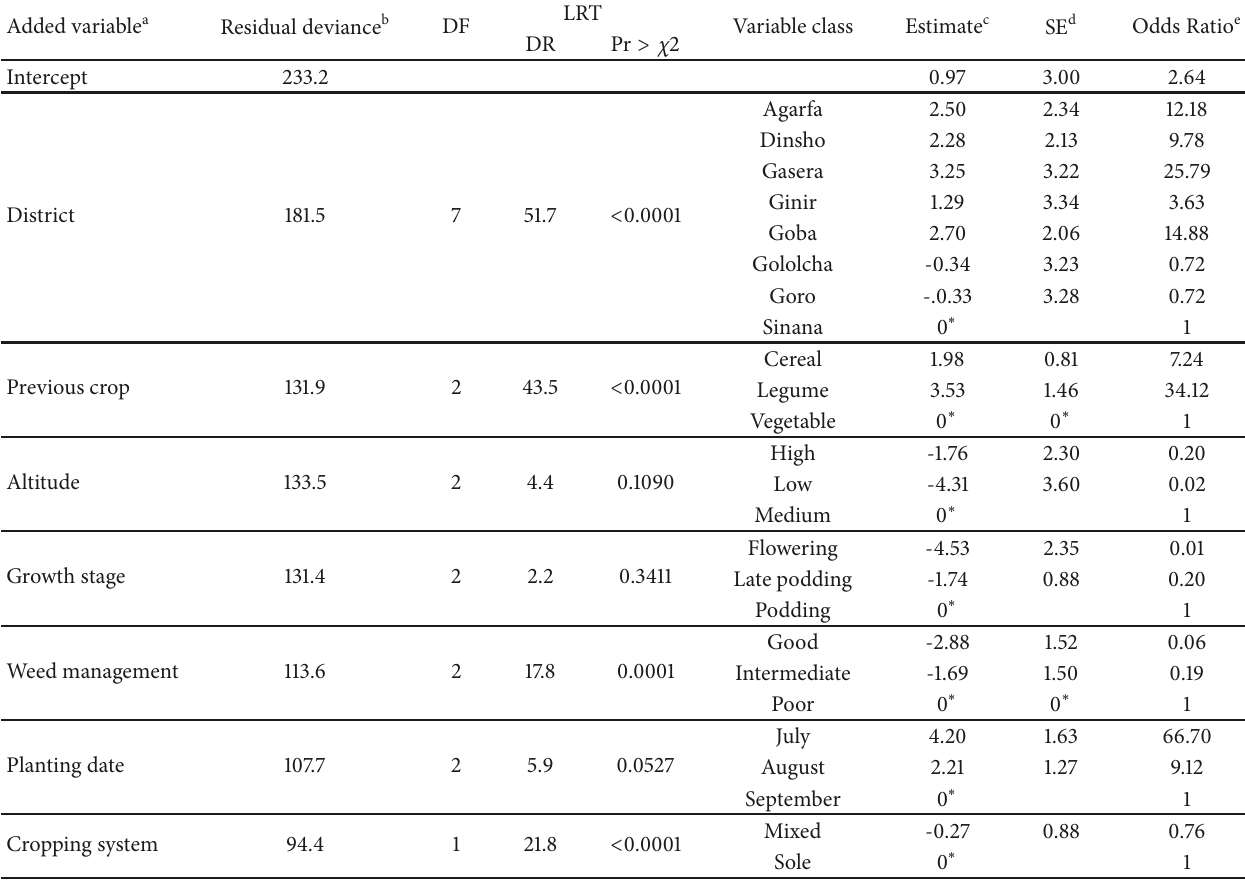
Table 5: Analysis of deviance,natural logarithms of odds ratio, and standard error of added variables in a reduced model analyzing chocolate spot